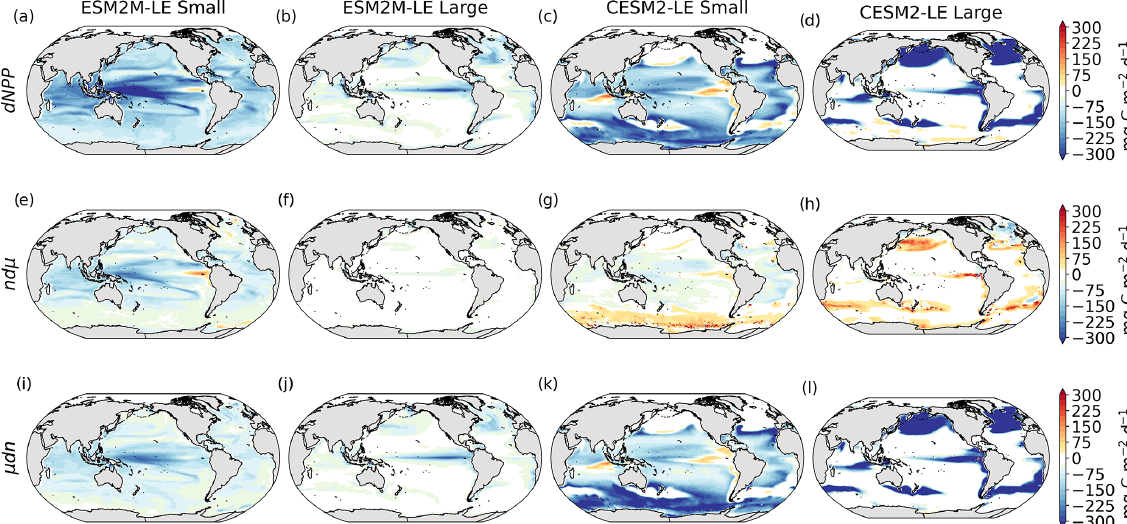
Figure 3. Small- and large-phytoplankton NPP anomalies, dNPP, relative to the climatological seasonal cycle (mgCm − 2 d − 1 ) during com- pound MHW–NPPX events in ESM2M-LE (a, b) and in CESM2-LE (c, d) and contributions of the growth rate n d µ (e–h) and of the biomass anomaly µ d n (i–l) to these NPP anomalies. Contours on panels (a) – (d) indicate the climatological mean state of small and large NPP averaged over 1998–2018 (see also Fig. B5a–d); labels have been